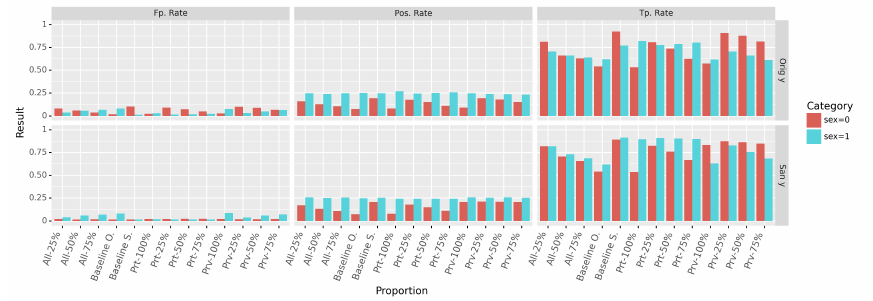
Figure 12. (Left to right) False Positive rates, predicted Positive Rates and True Positive Rates obtained in each group with GB when predicting the decision